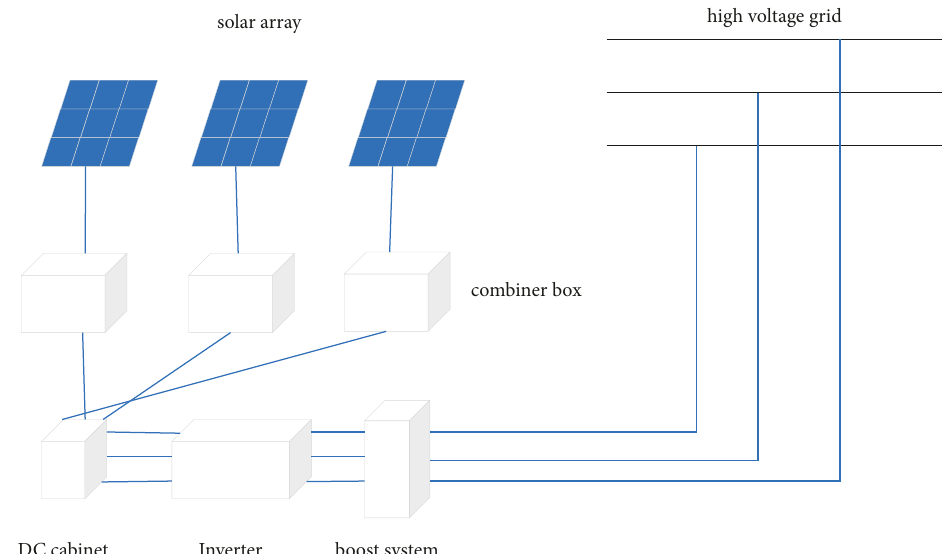
Figure 1: Composition of grid-connected photovoltaic power